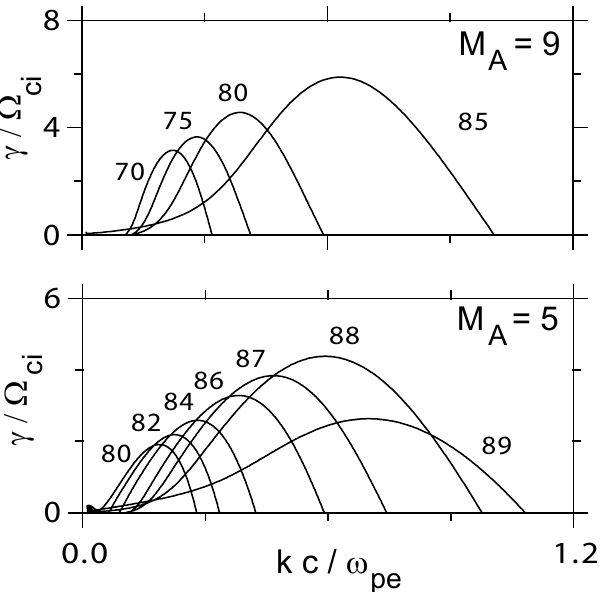
Fig. 5. Growth rate γ/(cid:127) ci versus k in units of ω pe /c for various values of the angle between the ion beams and the magnetic field. In the upper panel a velocity of M A = 9 has been assumed and in the lower panel a value of M A = 5 was assumed.